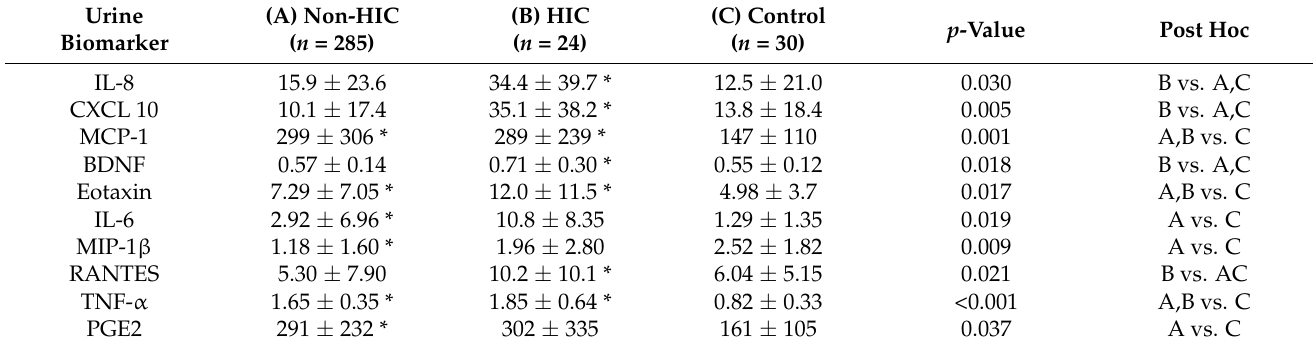
Table 1. Urinary biomarker levels between overall patients with interstitial cystitis/bladder pain syndrome with and without Hunner’s lesion and